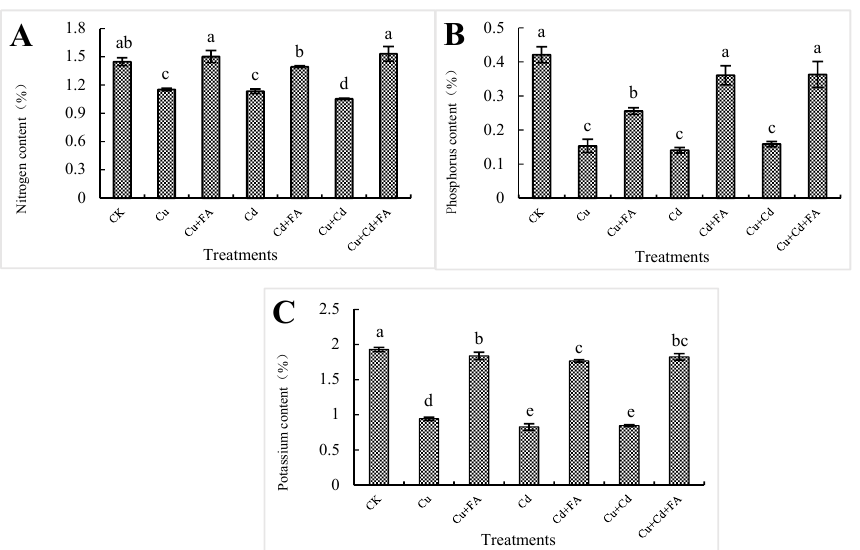
Figure 5. Alleviating Effects of FA on N ( A ), P ( B ), and K ( C ) of tomato fruit under different Cu, Cd stress. The same alphabet above each column shows no significance ( p > 0.05), in contrast, having significance ( p <